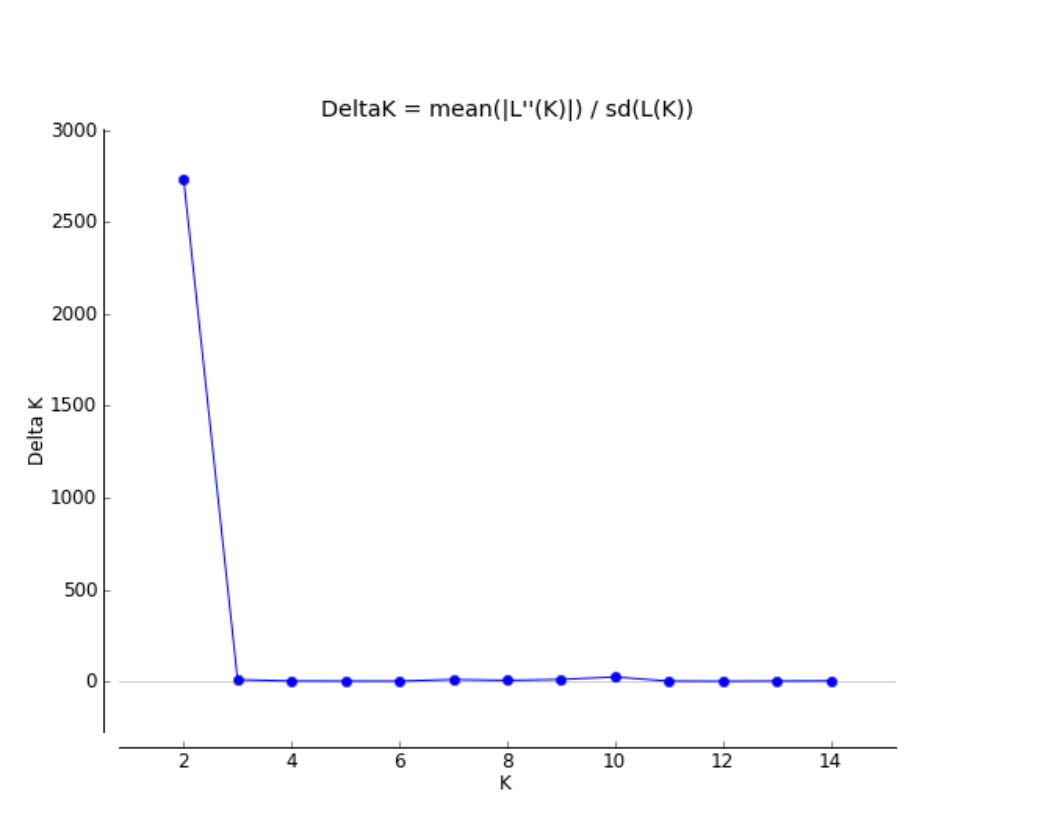
Figure A2.1. Most likely number of population clusters (K = 2) identified by the Evanno method (Evanno et al. 2005) using Structure Harvester v0.6.94 (Earl and vonHoldt